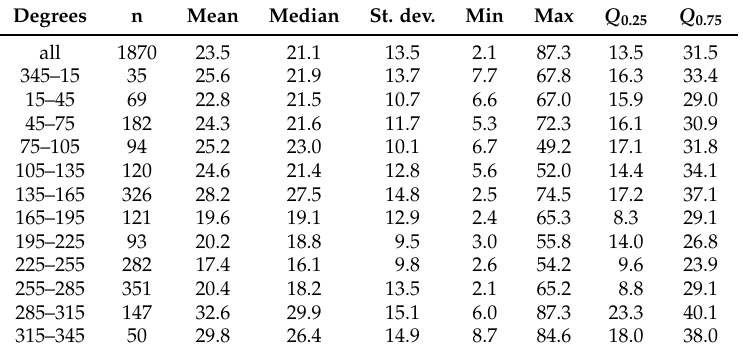
Descriptive statistics for PM 10 by wind direction: ˇCerná Pole station